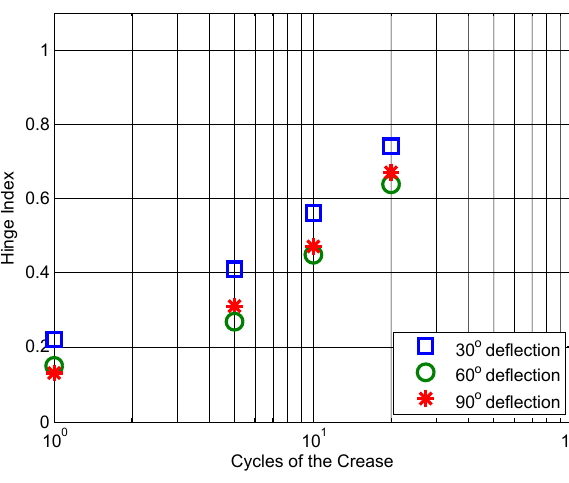
Figure 9. Cardstock (0.25 mm thick): hinge index verses cycles of the crease. A strong asymptotic behavior is seen.